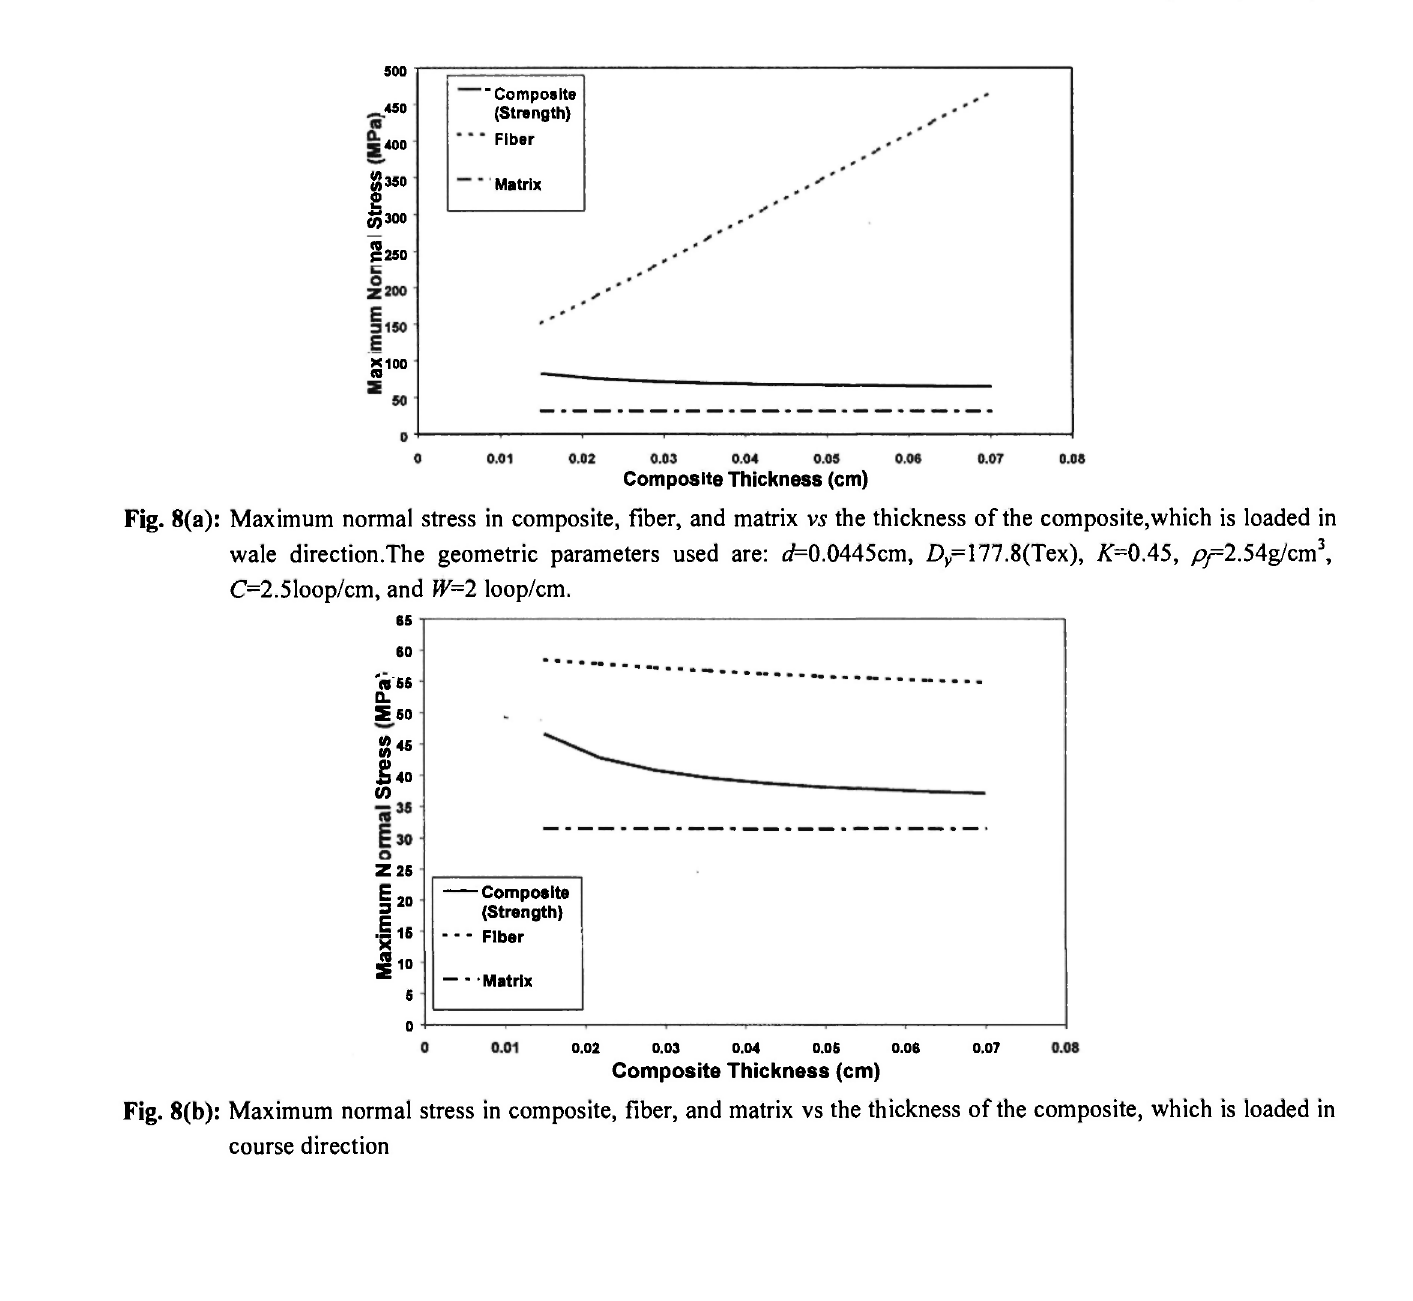
Fig. 8(b): Maximum normal stress in composite, fiber, and matrix vs the thickness of the composite, which is loaded in course